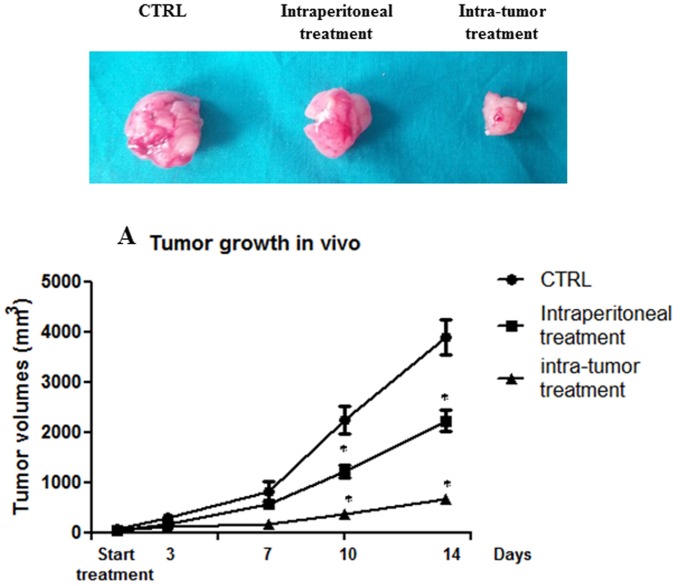

In vivo effects of ISA27 on GBM growth.After inoculation of U87MG cells into BALB/c nude mice, tumor growth was measured twice a week (for 14 days of treatment) with a caliper. Both intra-peritoneal (5 mg/kg) and intra-tumoral (3 mg/kg) treatments with ISA27 delayed tumor growth compared with controls. As shown in the graph, the intra-tumoral treatment was more effective for inhibition of tumor growth. The figure also shows a representative image of tumors at the end of the treatment. All values are presented as the mean of the values observed in mice from the same group (5 mice/group). Two-way ANOVA was performed to compare the different parameters among the different groups. A significance level of P<0.05 was assumed for all statistical evaluations. Statistics were computed using GraphPad Prism software.